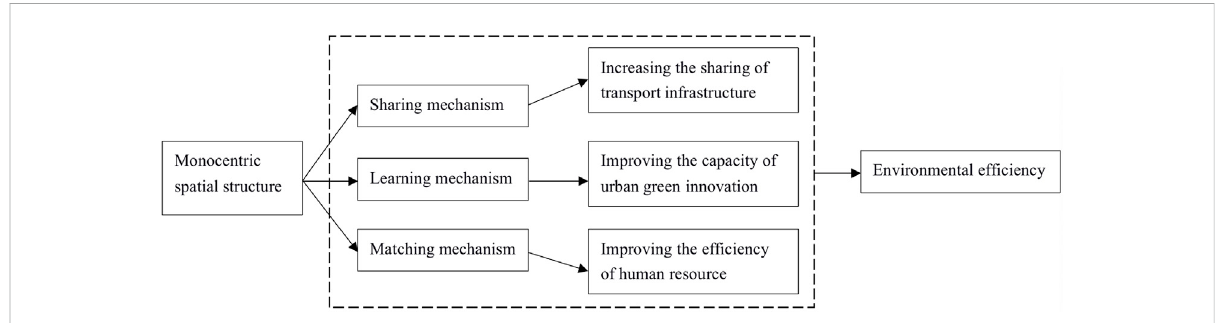
FIGURE 1 The in fl uence mechanism of spatial structure on environmental ef fi